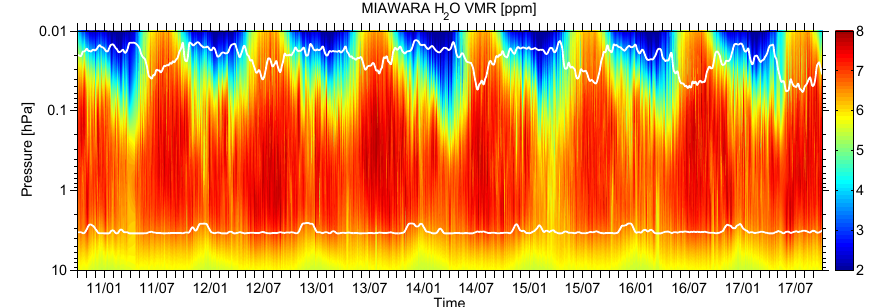
Figure 1. Water vapor volume mixing ratio (ppm) time series as measured by the MIAWARA microwave radiometer between October 2010 and September 2017. The horizontal white lines indicate at which pressure levels the measurement response drops below 50%. Clearly seen is the annual cycle in the mesosphere with an H 2 O maximum in summer. The measurement response is affected by tropospheric opacity, which is higher in summer and leads to the observed variation in